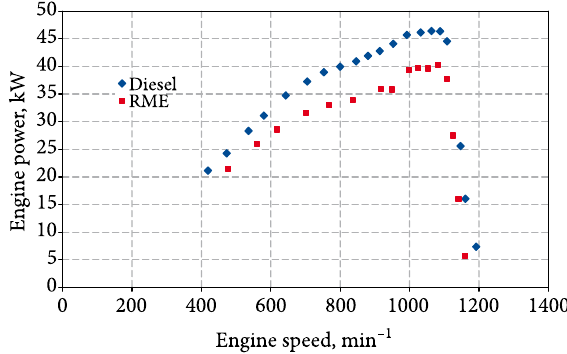
Fig. 1. Comparison of the engine power using pure diesel fuel and pure RME